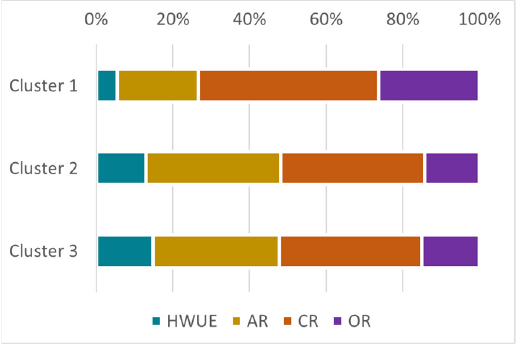
Figure 8. The proportions of links in three clusters. (HWUE: highways and urban expressways, AR: arterial roads, CR: collector roads, OR: other roads).